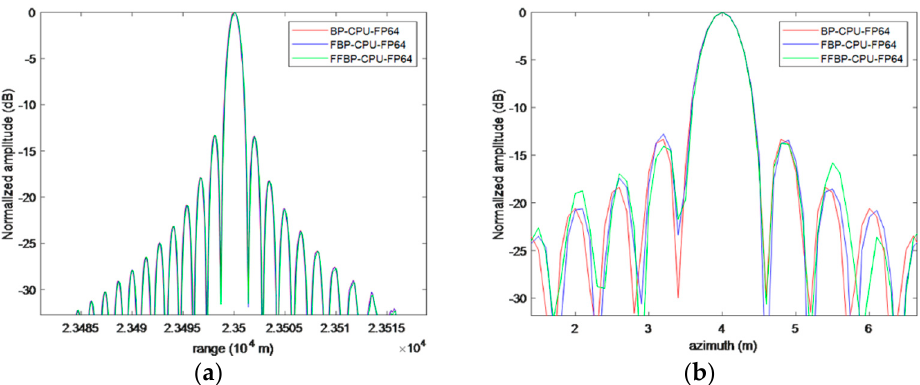
Figure 10. The normalized amplitude diagrams of three CPU schemes for a point target. ( a ) In range